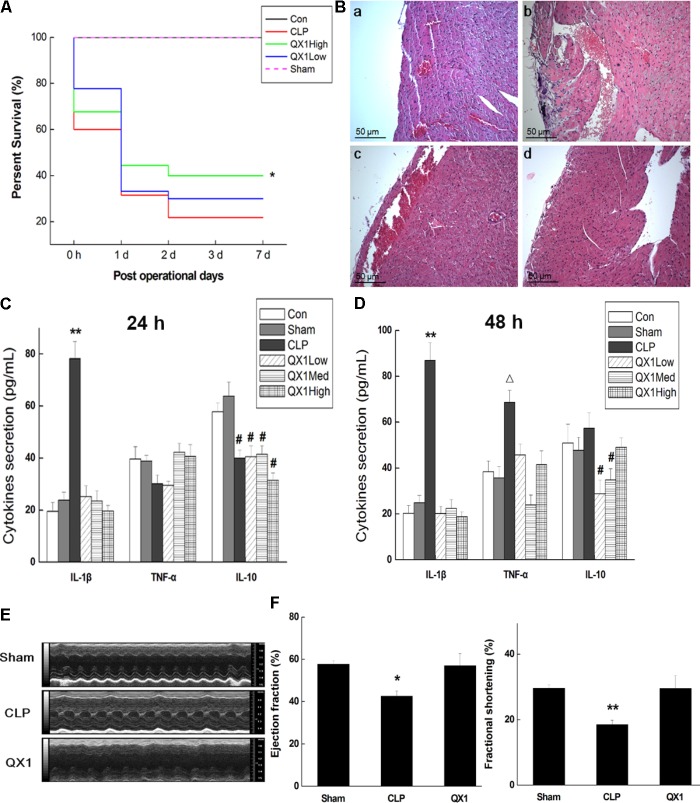
QX1 treatment improves survival rate of CLP mice. QX1 formula was orally administrated 2 h after surgery. The dosages of QX1 formula used for this study, indicated as low dose, medium dose, and high dose, were 0.25, 0.5, and 1 g/kg⋅bw, respectively. (A) Kaplan–Meier curves for survival rate. Thirty mice of each treatment group were used for comparison. The observation of mortality continued for 7 days, ∗p < 0.05 indicates significant difference compared with CLP surgery group. (B) H&E staining of heart tissue in each group. (a) Control group, (b) CLP surgery group, (c) QX1 high dose group, (d) sham group. (C) ELISA detection on expression of serum cytokines (24 h after surgery). ∗∗p < 0.01 and #p < 0.05 indicate significant differences compared with sham group. (D) ELISA detection on expression of serum cytokines (48 h after surgery). ∗∗p < 0.01, Δp < 0.05 and #p < 0.05 indicate significant differences compared with sham group. (E) Echocardiography was employed to evaluate changes in heart function of mice in sham group, CLP group, and high dose QX1 treatment group. (F) Evaluation of the ejection fraction (EF %) and fractional shortening (FS %) of mice in sham group, CLP group, and high dose QX1 treatment group.